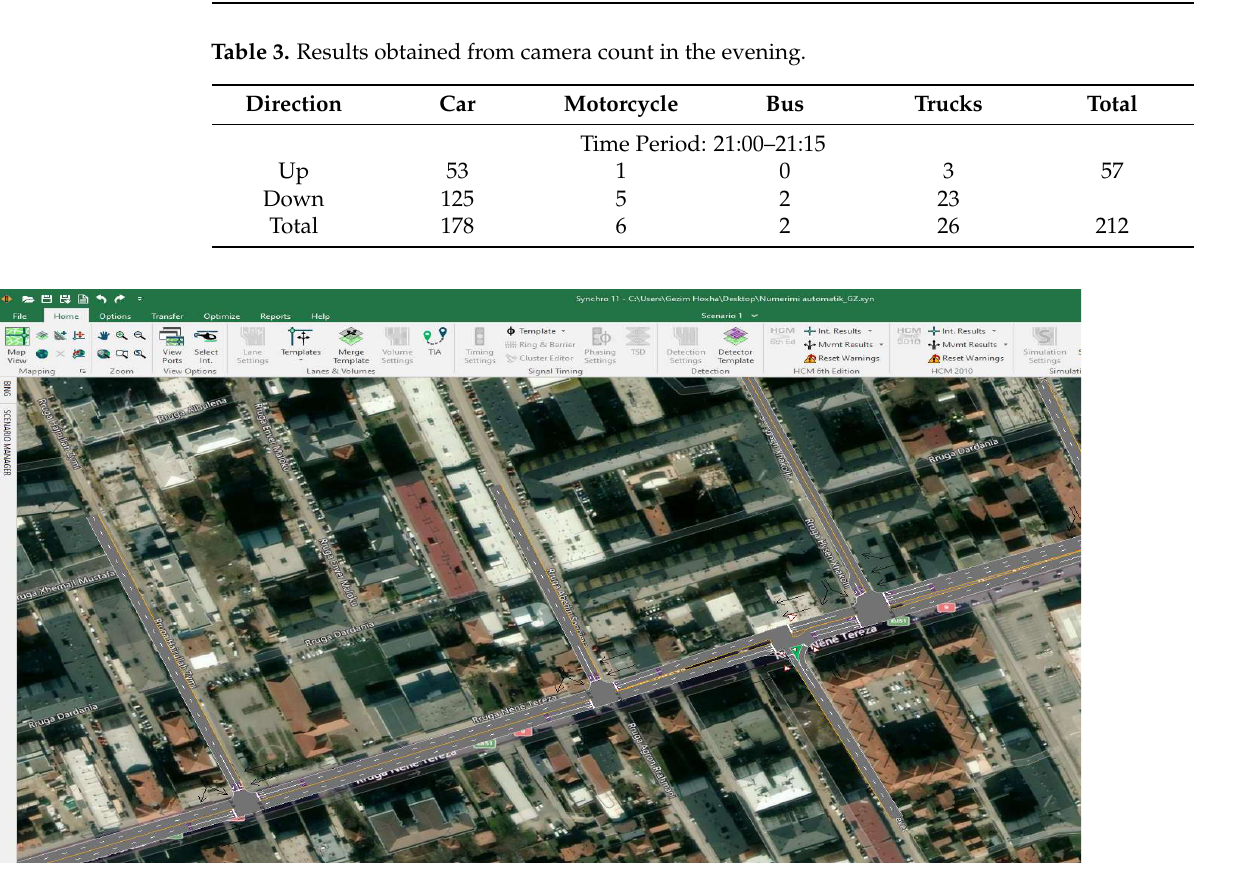
Figure 7. Road traffic network in “Synchro” model. Table 4. Results obtained from camera count in the different time Table 3. Results obtained from camera count in the evening.